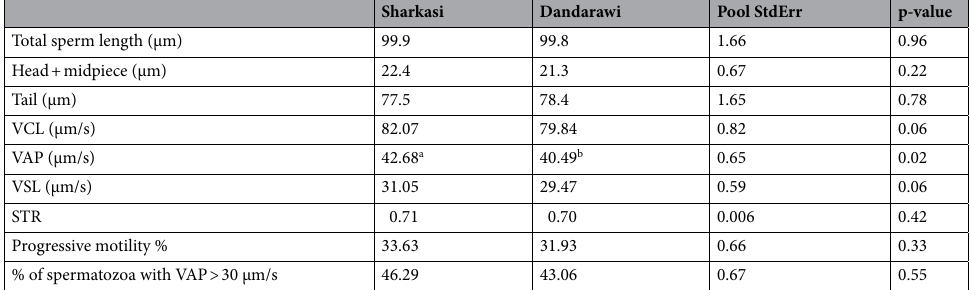
Table 2. Sperm morphometric measures (n = 30 sperm per rooster; length of entire sperm, head + midpiece, and tail), sperm velocity values, progressive motility % and spermatozoa with VAP > 30 μm/s % in Sharkasi and Dandarawi ejaculates (n = 5 samples per rooster). Means ± SEM was used to express all measurements. VCL curvilinear velocity, VAP average path velocity, VSL straight line velocity; STR = VSL/VAP. a,b For main effects, means within a row without common superscripts differ significantly ( p < 0.05).